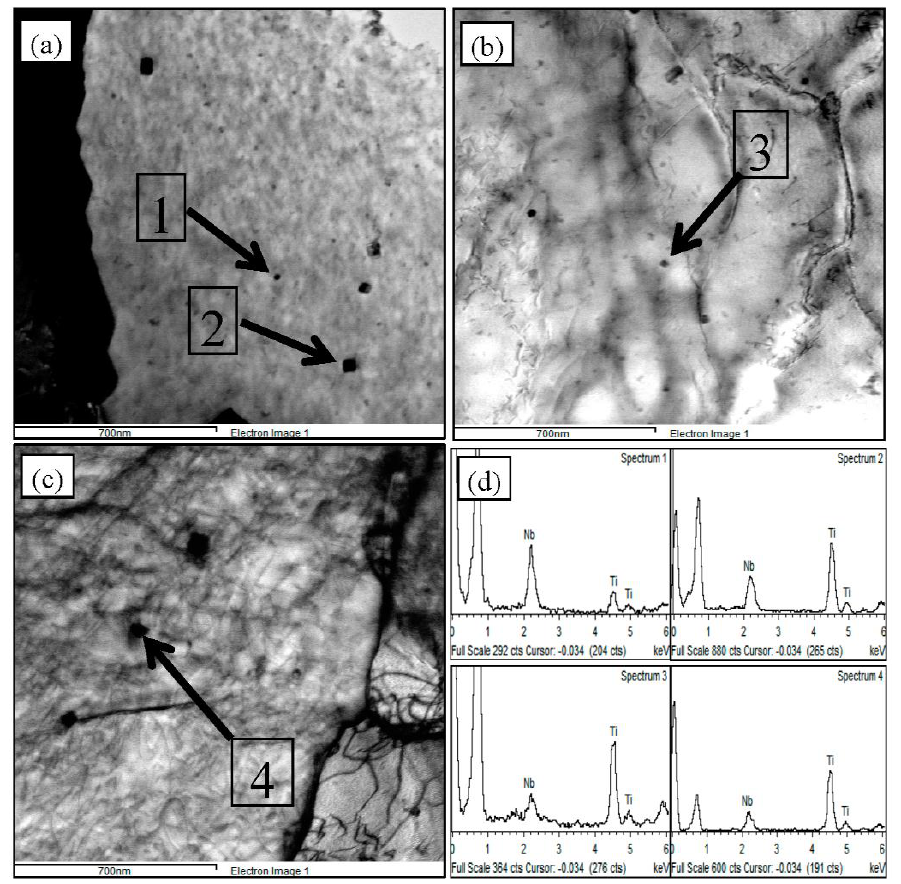
Figure 6. TEM observations of precipitate in samples of: ( a ) 5 °C/s; ( b ) 15 °C/s; and ( c ) 20 °C/s; and ( d ) their energy dispersive X-ray (EDX) analyses.